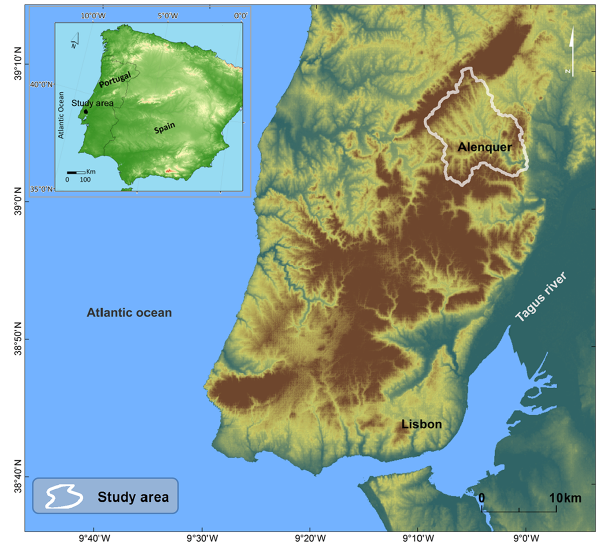
Figure 1. Location of Alenquer study